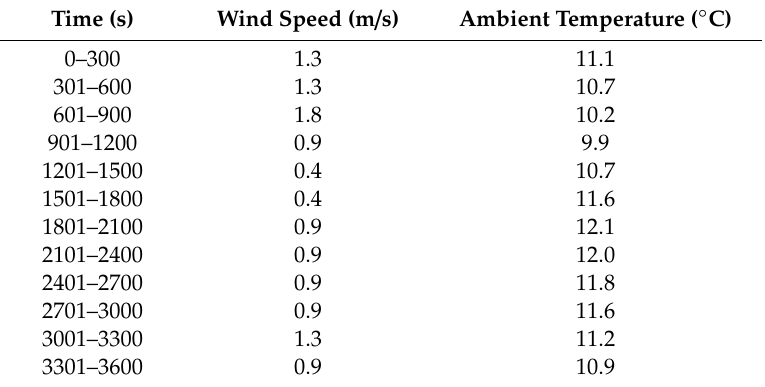
Table 8. Meteorological data of rating in winter.